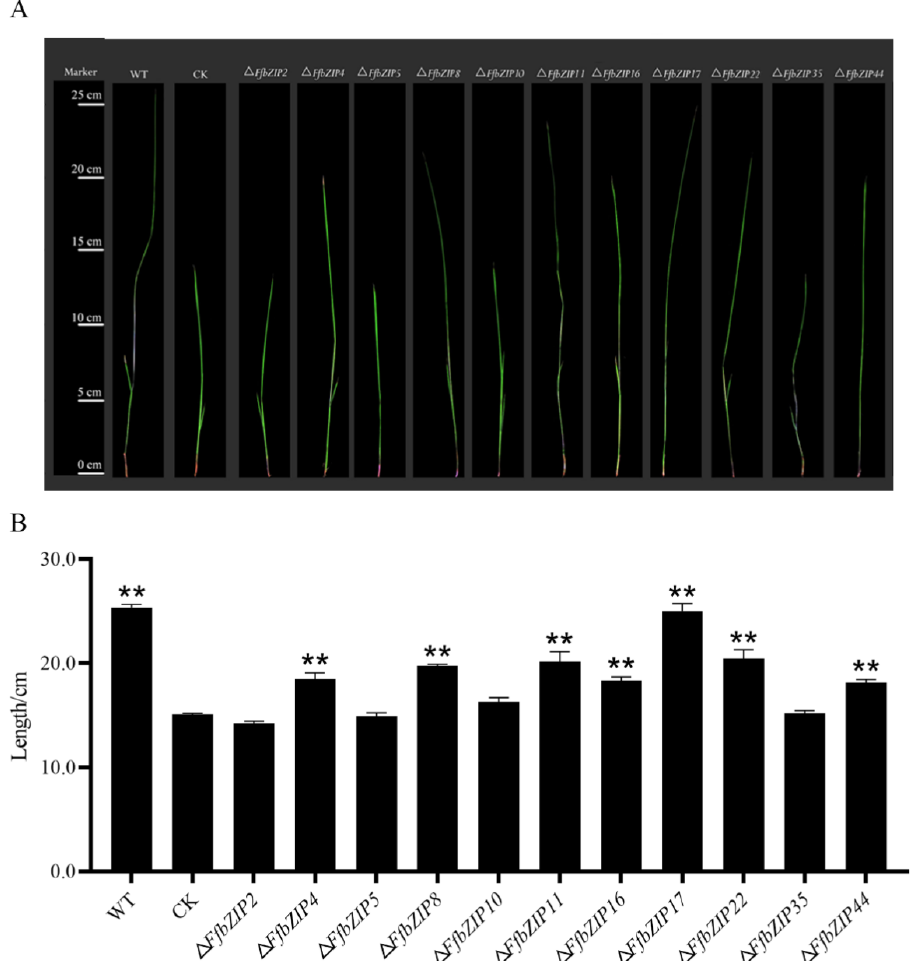
Figure 10. Pathogenicity observation of inoculated rice seedlings. ( A ) Pathogenicity alignment of FfbZIP knockout mutants and wild type. ( B ) Shoot length determination of rice seedlings inoculated with wild type and FfbZIP deletion mutants. CK stood for the shoot length of uninoculated rice seedlings, ** p < 0.01.